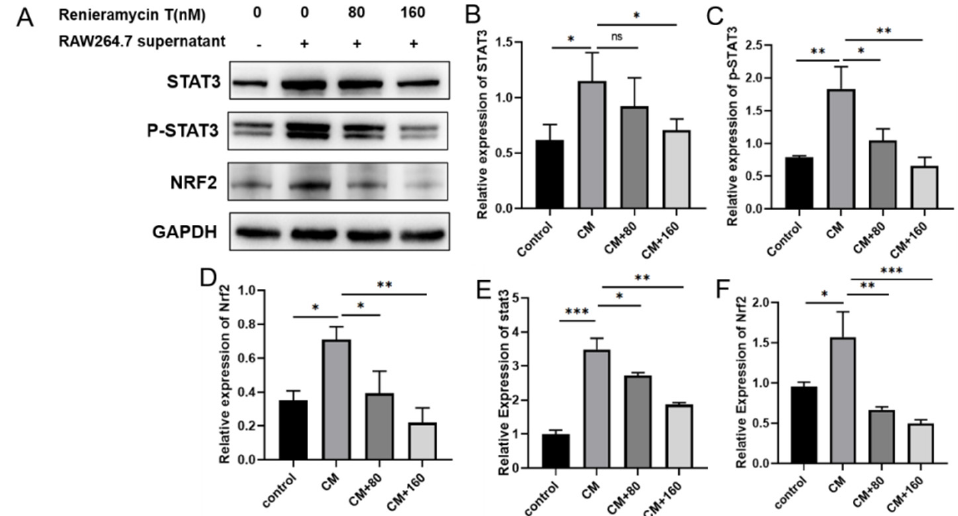
Figure 4. RT repressed the phosphorylation of STAT3 and down-regulated the expression Nrf2 in B16F10 cells. ( A ) The expression of STAT3, p-STAT3, and Nrf2 proteins were detected by WB assay; ( B – D ) The relative expression level of p-STAT3, STAT3, and Nrf2 proteins were analyzed in the B16F10 (* p < 0.05, ** p < 0.01); ( E , F ) The relative expression of STAT3 and Nrf2 were detected by qRT-PCR (* p < 0.05, ** p < 0.01, *** p < 0.001).